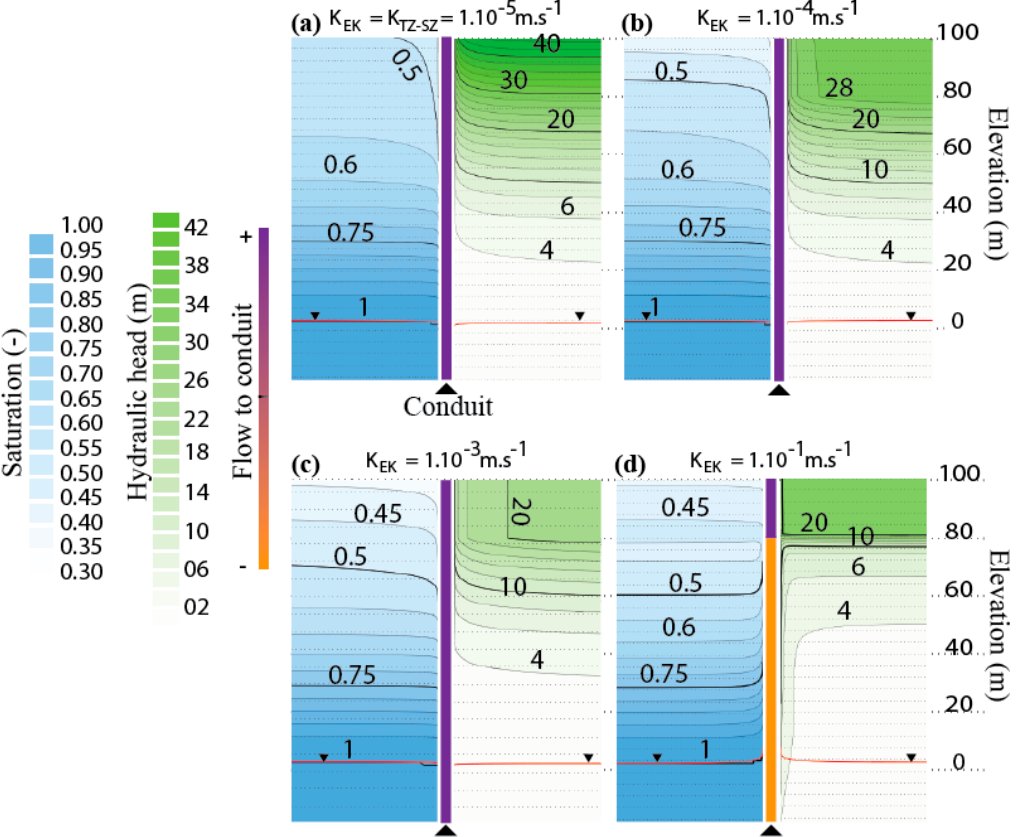
Figure 5. Profiles of the saturation (blue) and hydraulic head (green) around the conduit for various values of hydraulic conductivity of the epikarst. Each profile is taken at the time step for which the flux at the bottom output of the model is maximum. ( a ) The hydraulic conductivity is the same throughout the entire model and equal to 10 − 5 m / s. ( b ) The epikarst hydraulic conductivity is equal to 10 − 4 m / s. ( c ) The epikarst hydraulic conductivity is equal to 10 − 3 m / s. ( d ) The epikarst hydraulic conductivity is equal to 10 − 1 m / s.